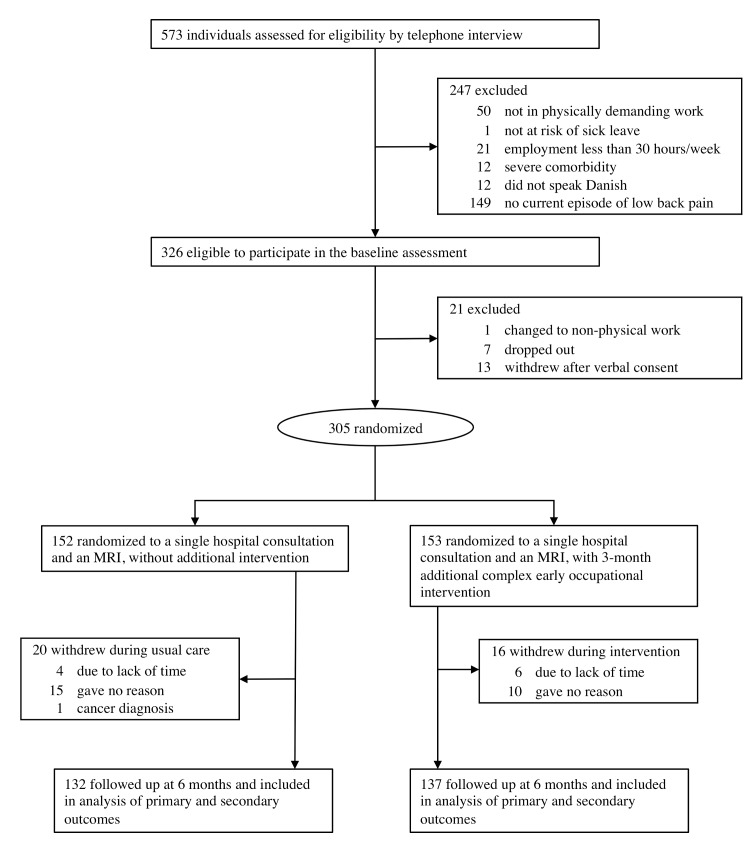
Flow of participants through the trial.